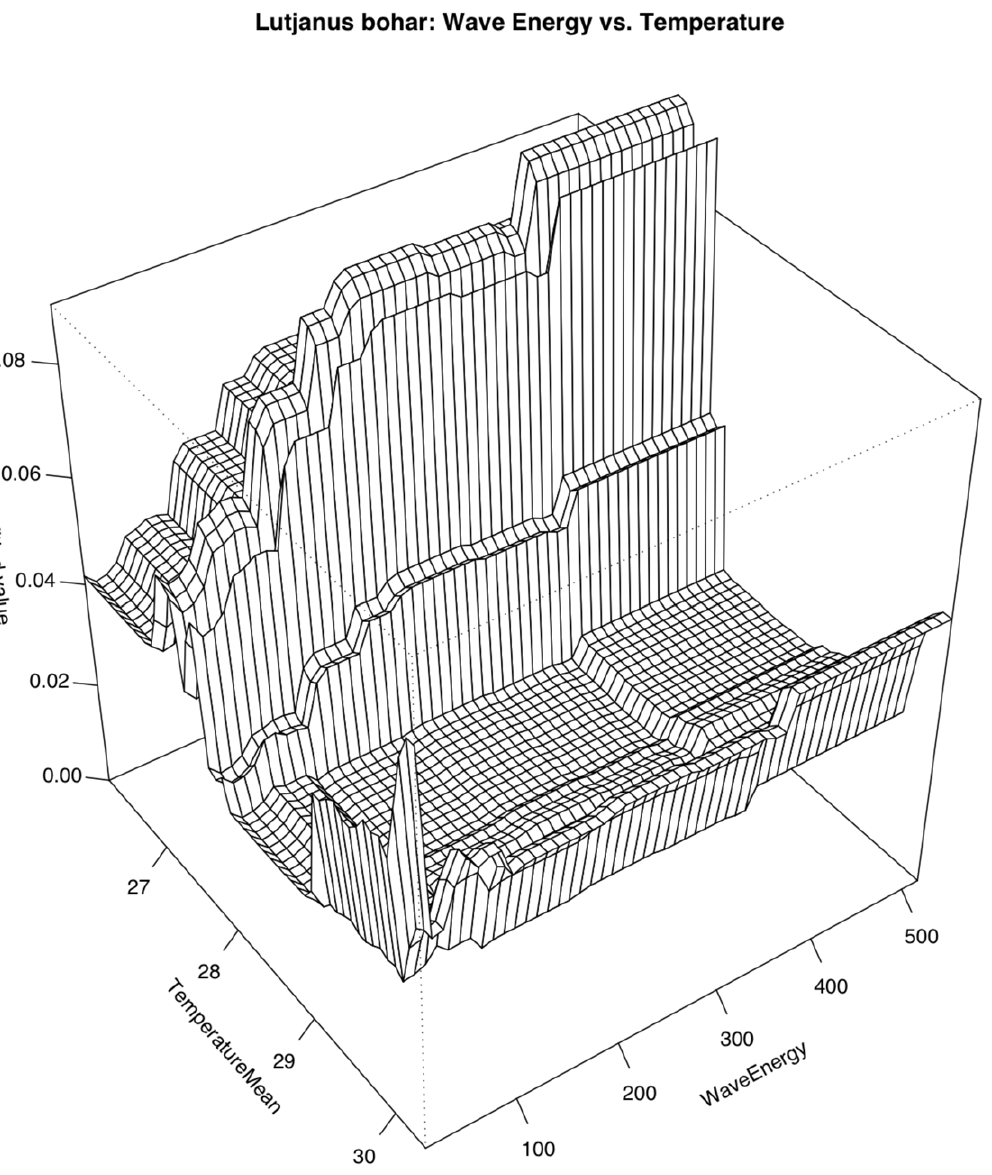
Figure 8. Pairwise interaction between wave energy and temperature with respect to occurrence of Lutjanusbohar . The effect of temperature is magnified by wave energy while wave energy is primarily influential at temperatures below 28 u C. among variables shows that variables including depth and wave energy are only influential in areas with the lowest human population densities. While the absolute influence of each variable was relatively low in this highly variable data set, oceanographic factors such as depth, temperature, and proximity to deep water (quantified as distance to the 50-m depth contour) consistently the most influential of the factors we analyzed. In almost all cases, species occurrence increased in deeper waters and in areas of higher temperature. The effects of temperature and depth were synergistic with respect to total large-bodied reef fish biomass, with the effect of each being magnified by the other. Depth was particularly important for Cheilinus undulatus , which was only observed on surveys in greater than 15 m. Caranx melampygus and Scarus rubroviolaceus displayed an inverse relationship with respect to depth, which highlights their differing niches. Carnivorous C.